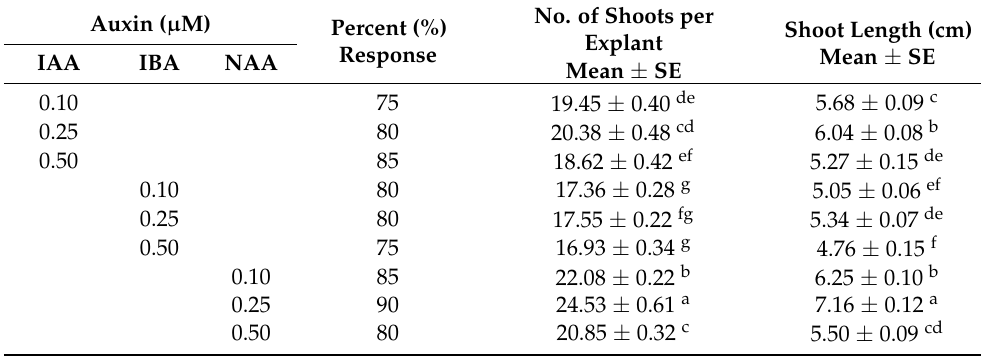
Table 4. Combined effect of different concentrations of auxins in combination with optimal cytokinin (1.0 µ M BA) on multiple shoot proliferation from node explants of L. speciosa after 12 weeks of culture. Auxin ( µ